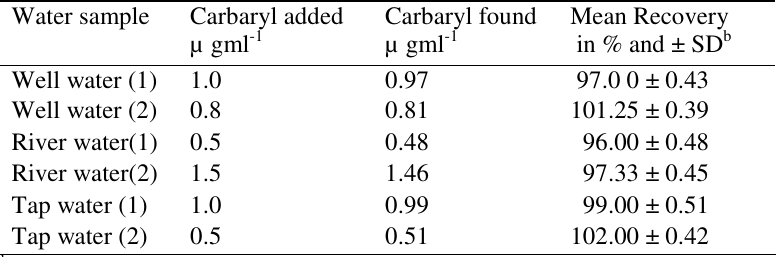
Table 4 . Recovery of Carbaryl residues from grain samples